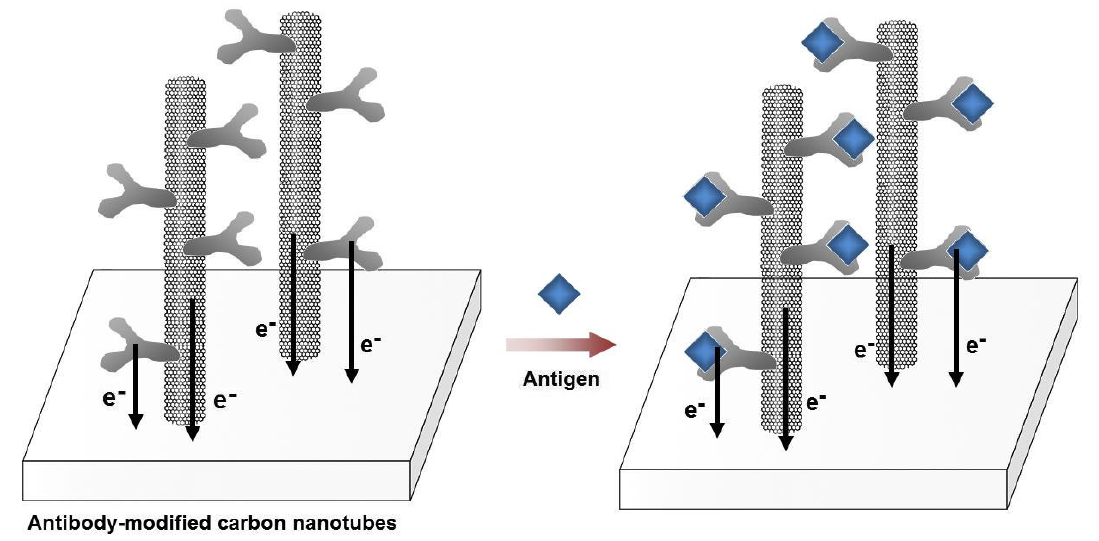
Figure 5. Schematic illustration of the label-free immunosensors using single-walled carbon nanotubes (SWCNTs). SWCNTs were grown directly on the platinum electrode surface. Upon the covalent attachment of the antibodies on the SWCNTs, a current response is recorded from the intrinsic electro- activity of the antibodies. As the antigens are bound with the antibodies, the electrochemical responses change. The current height at the peak oxidation potential (~0.5 V vs. Ag/AgCl) increases or decreases depending on the concentration of the bound